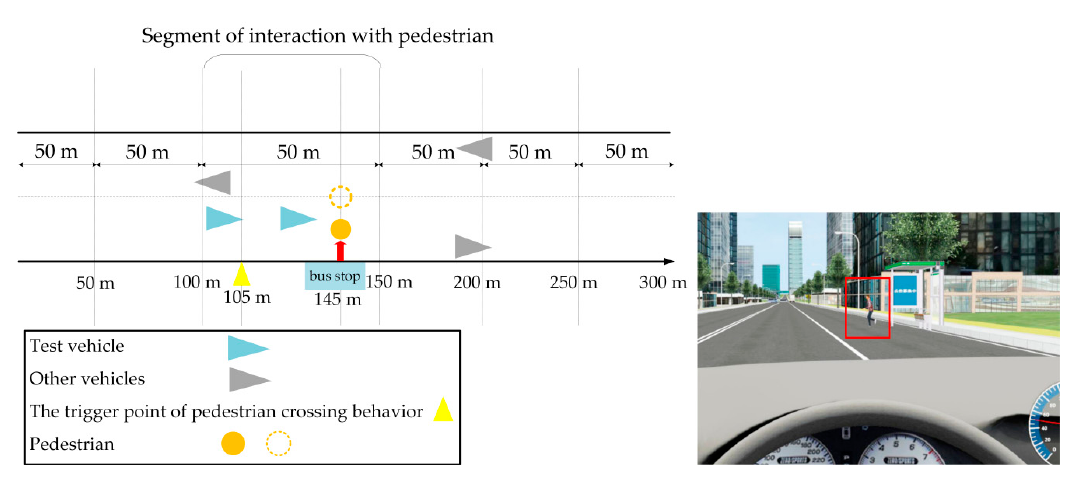
Figure 3. Schematic diagram of low-risk scenario.